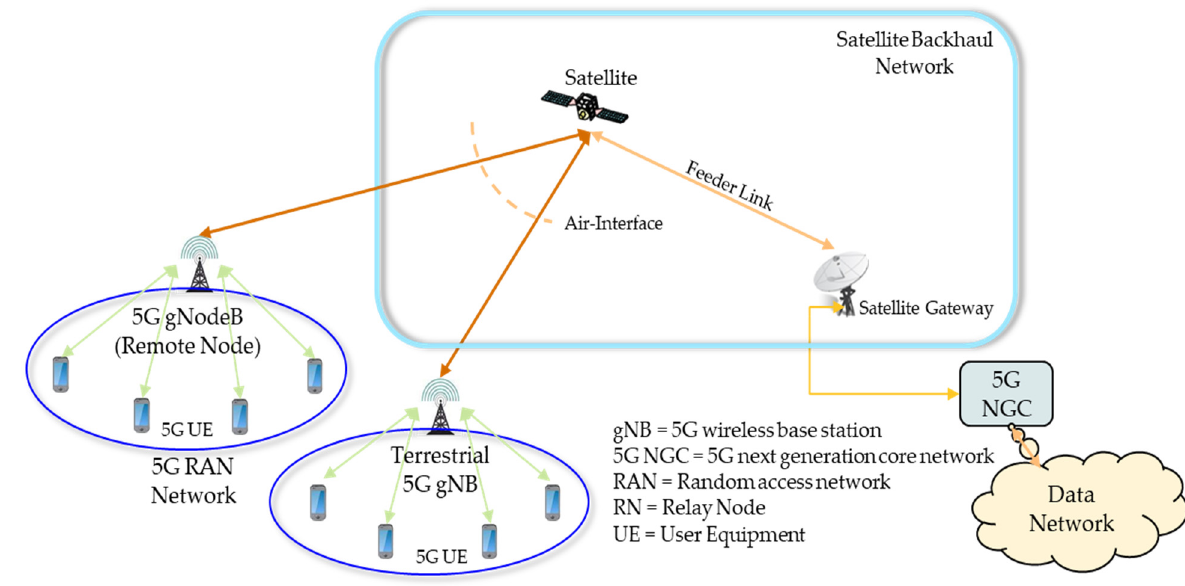
Figure 6. Strawman SATis5 Architecture for Short-Term Solution.